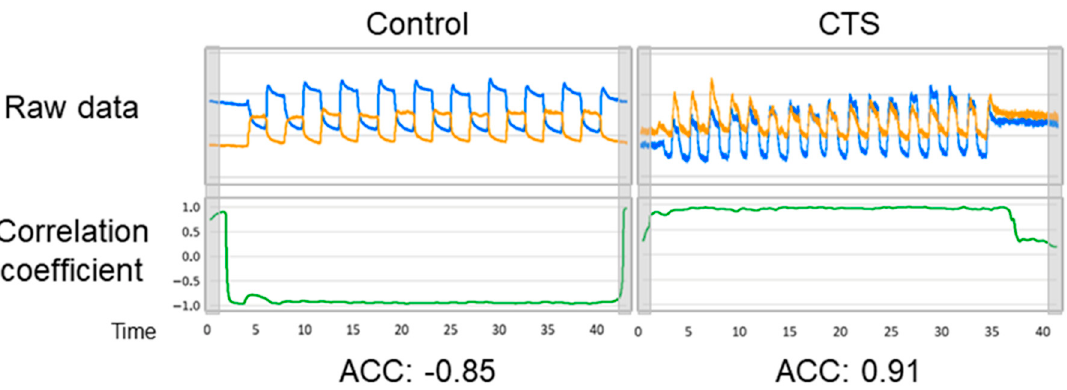
Figure 5. Representative examples of the correlation coefficient transition graphs in the control and carpal tunnel syndrome (CTS) groups. The average correlation coefficient (ACC) was calculated according to the above-mentioned method. The gray squares are the areas excluded in the ACC calculation.